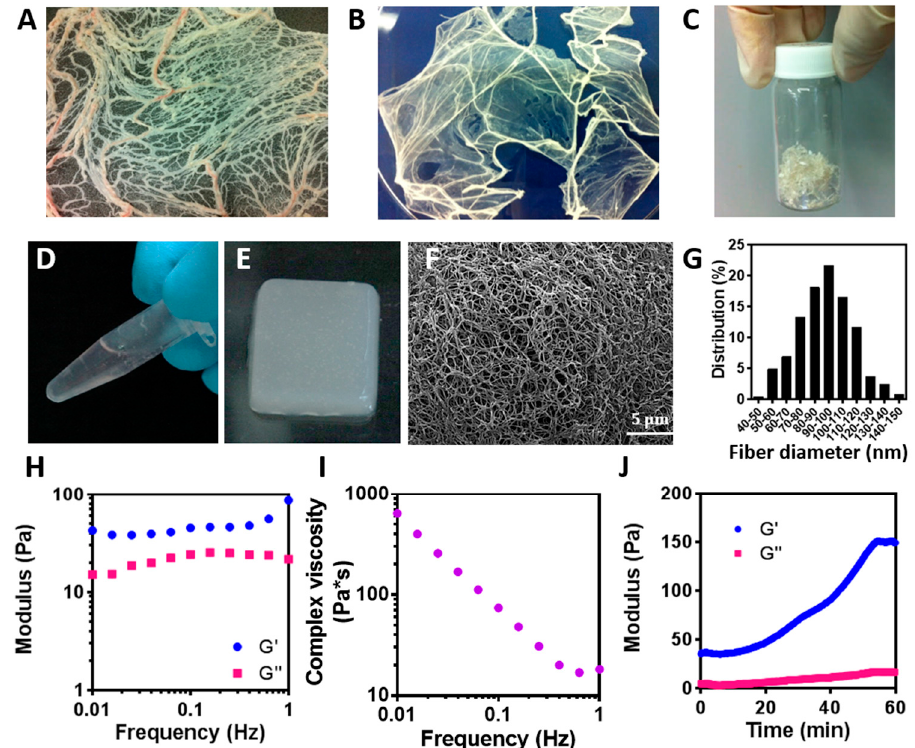
Figure 2. Hydrogel preparation process and characterization. ( A ) Fresh omentum, prior to decellularization process. ( B ) Omentum after complete decellularization and lyophilization. ( C ) Milled decellularized omentum powder. ( D ) Omentum-based hydrogel at room temperature. ( E ) The omentum-based hydrogel under physiological conditions. ( F ) SEM of the nanofibrous structure of the hydrogel. ( G ) Fiber diameter distribution. ( H–J) Omentum-based hydrogel rheology. ( H ) Storage G’ (blue) and loss G” (pink) modulus versus frequency. ( I ) Complex viscosity of omentum-based hydrogel versus frequency plots. ( J ) Representative curves of storage (G’; blue) and the loss modulus (G”; pink) during gelation at 37 °C.